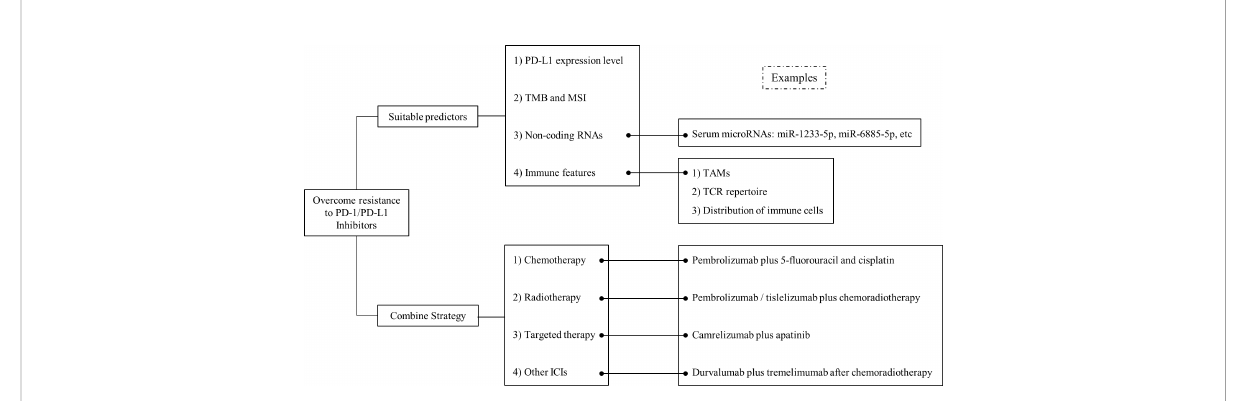
FIGURE 2 Overview on the strategies to overcome drug resistance to PD-1/PD-L1 inhibitors in EC. Strategies including suitable predictors and combined therapy, have been proposed to improve the effect of PD-1/PD-L1 inhibitors in